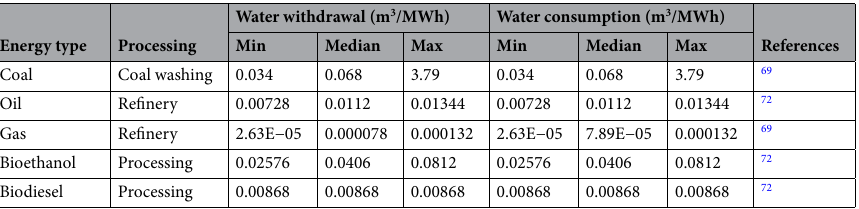
Table 6. Water intensity data in the midstream